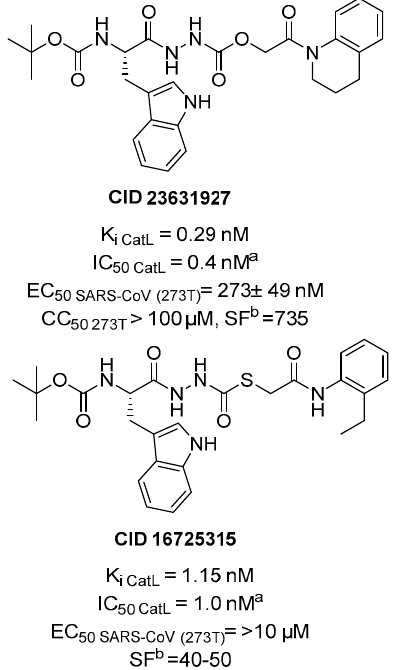
Figure 18. Structures and biological activities of tetrahydroquinoline oxocarbaze CID 23631927 and its analog CID 16725315 covalent reversible inhibitors of human CatL and anti-SARS-CoV-2 agents; a Preincubation for 4 h; b Cathepsin L / B selectivity ratio.